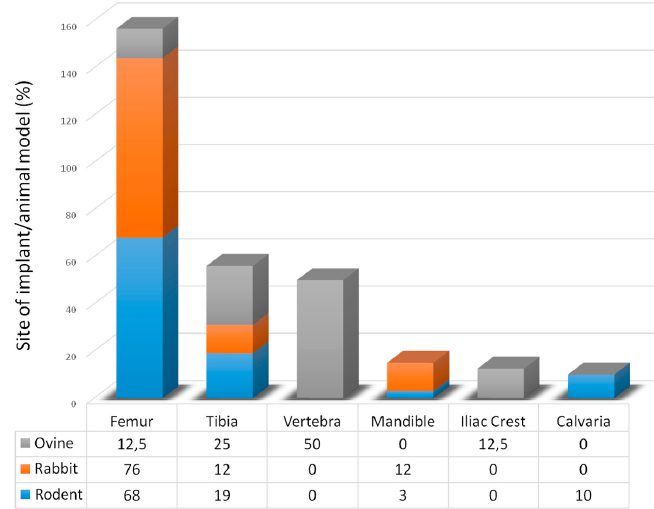
Figure 4. Analysis of the site of implant of functionalized materials described in the preclinical papers.